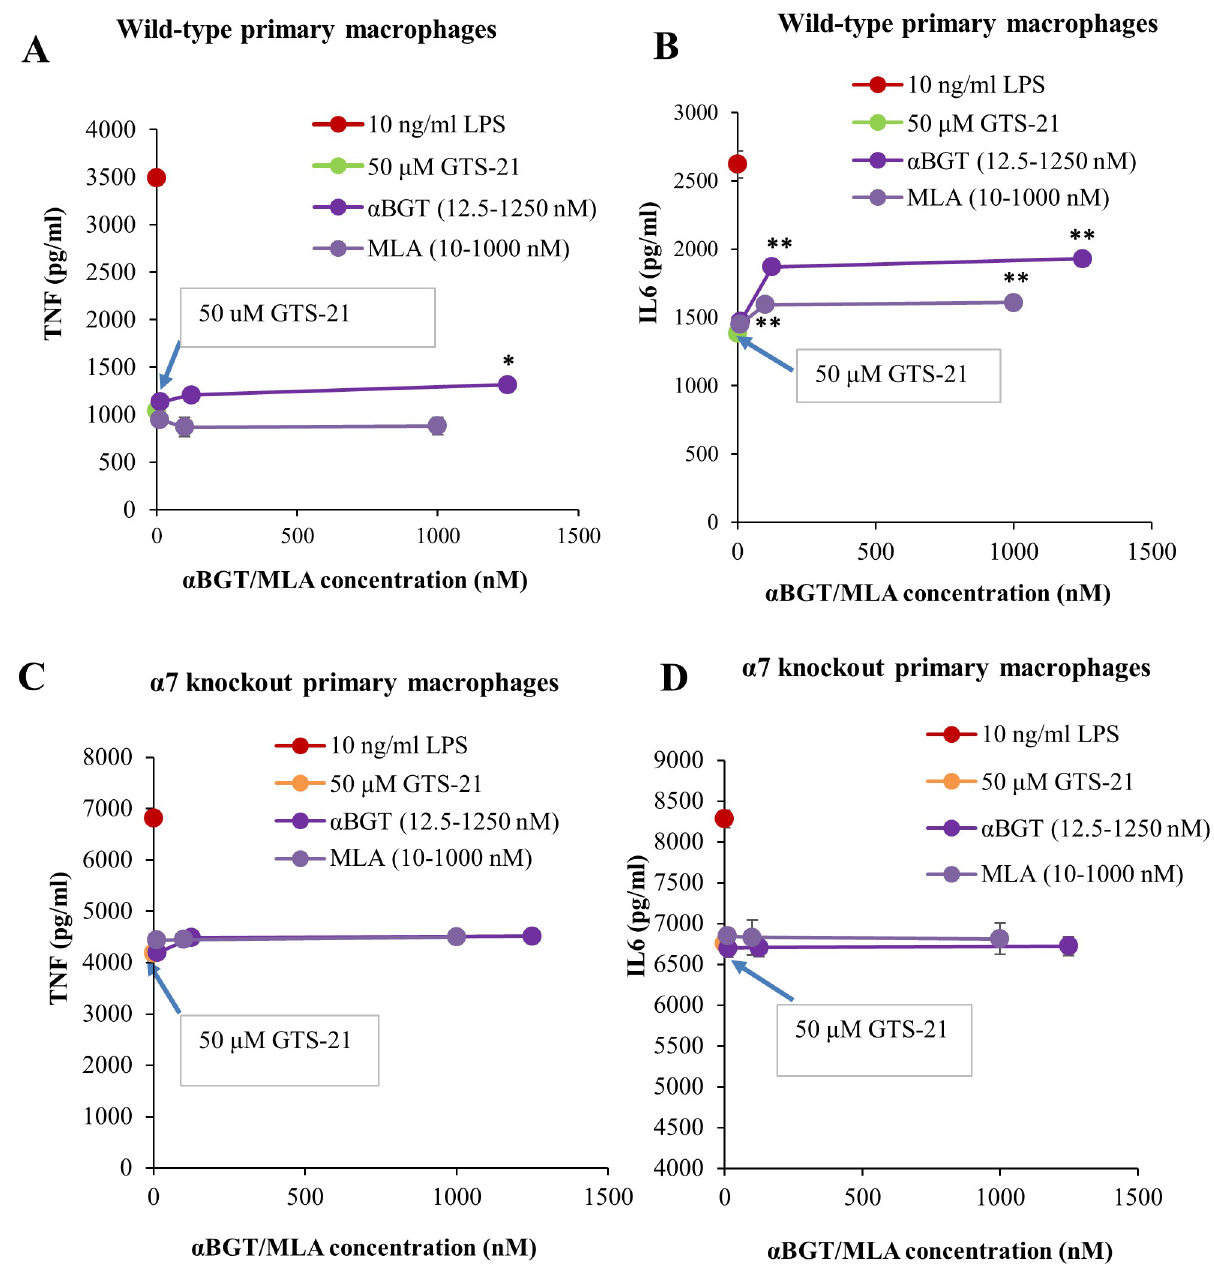
Fig 4. α 7 nAChR-independent anti-inflammatory effects of GTS-21 in WT and Chrna7 -/- mouse macrophages. (A) 50 μ M GTS-21 pre-treatment significantly blocked endotoxin-stimulated TNF and IL6 secretions and this concentration was selected to further study the effects of α 7 nAChR antagonists, α BGT and MLA. ELISA data showing approx. 10% reversal of GTS-21 block on TNF secretion by 1.25 μ M α BGT. No reversal was observed with MLA. ELISA data in panel (B) demonstrates 40% reversal of GTS-21 block on IL6 secretion by 1.25 μ M α BGT and 30% reversal by 1 μ M MLA. Neither α BGT nor MLA produced significant changes in the GTS-21 block of LPS-induced (C) TNF or (D) IL6 secretion in α 7 nAChR absence. One-way ANOVA (analysis of variance) with post-hoc Tukey HSD (honestly significant difference) test used to compare differences between multiple treatment groups. � P < 0.01, �� P < 0.001, ��� P < 0.0001. A duplicate of this experiment showed similar